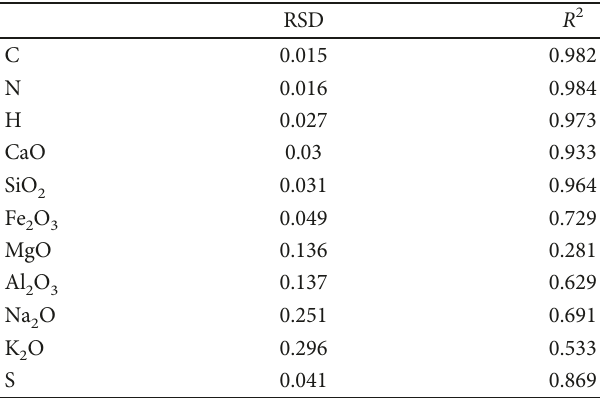
Table 2: RSD and R 2 for ingredients of oil